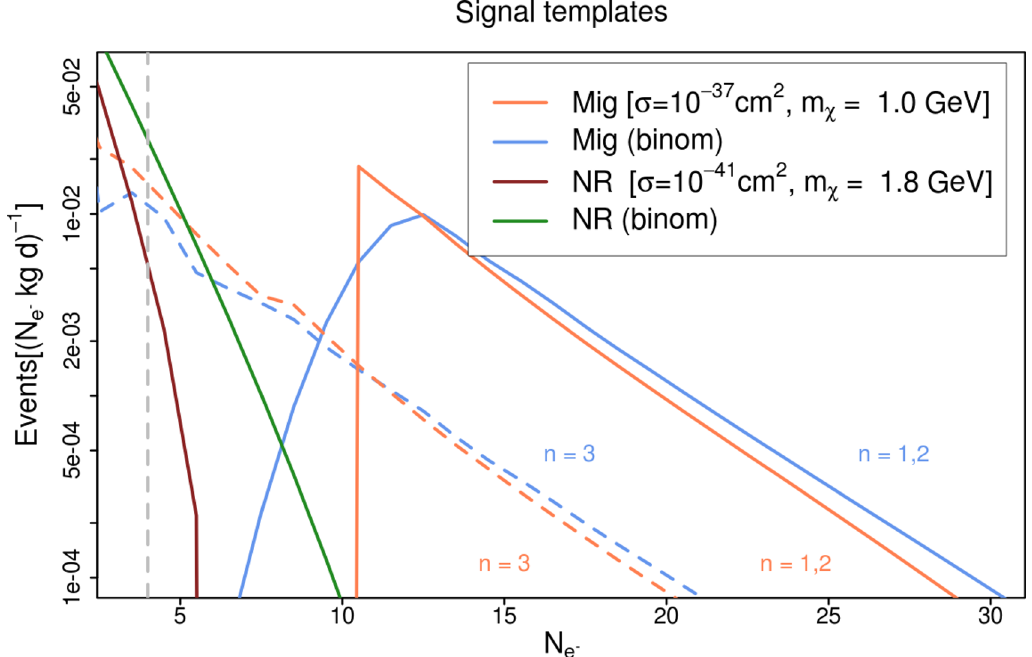
Figure 12 . Migdal electron signal for m (cid:31) = 1 GeV = c 2 (blue lines) and m (cid:31) = 1 GeV = c 2 folded with the binomial model for the detector response (orange lines), both evaluated for (cid:27) = 10 (cid:0) 37 cm 2 , considering only n = 1 ; 2 . The dashed lines represent the same signals including also n = 3 . NR for m (cid:31) = 1 : 8 GeV = c 2 and (cid:27) = 10 (cid:0) 41 cm 2 with the binomial model for the detector response (green line), without (brown